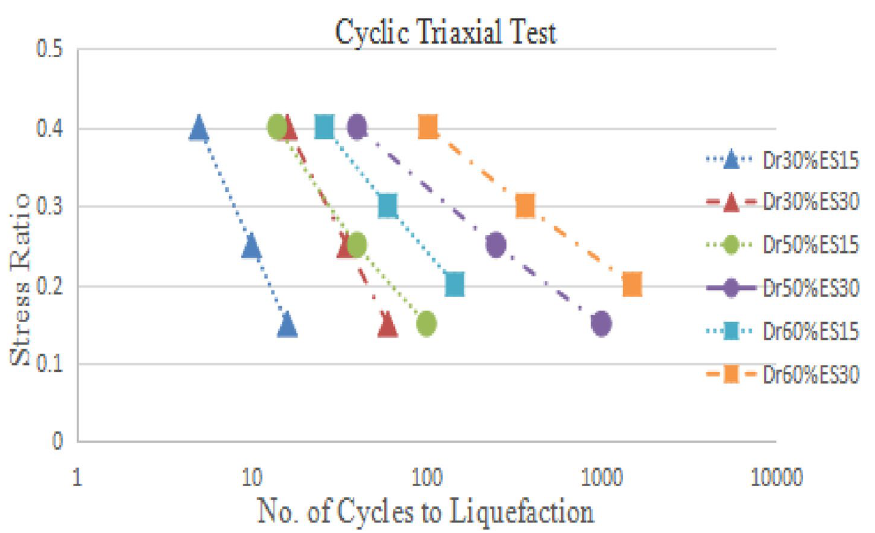
Figure 15. Stress ratio vs number of cycles to liquefaction in